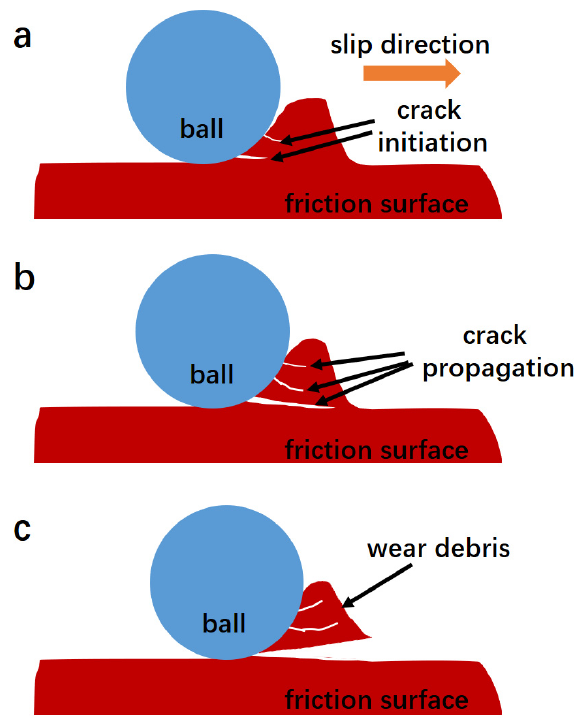
Figure 12. ( a ) Fatigue crack initiation on the wear surface; ( b ) Fatigue crack growth on the wear surface; ( c ) Fatigue cracks penetrated through the wear surface, and wear debris fell off.